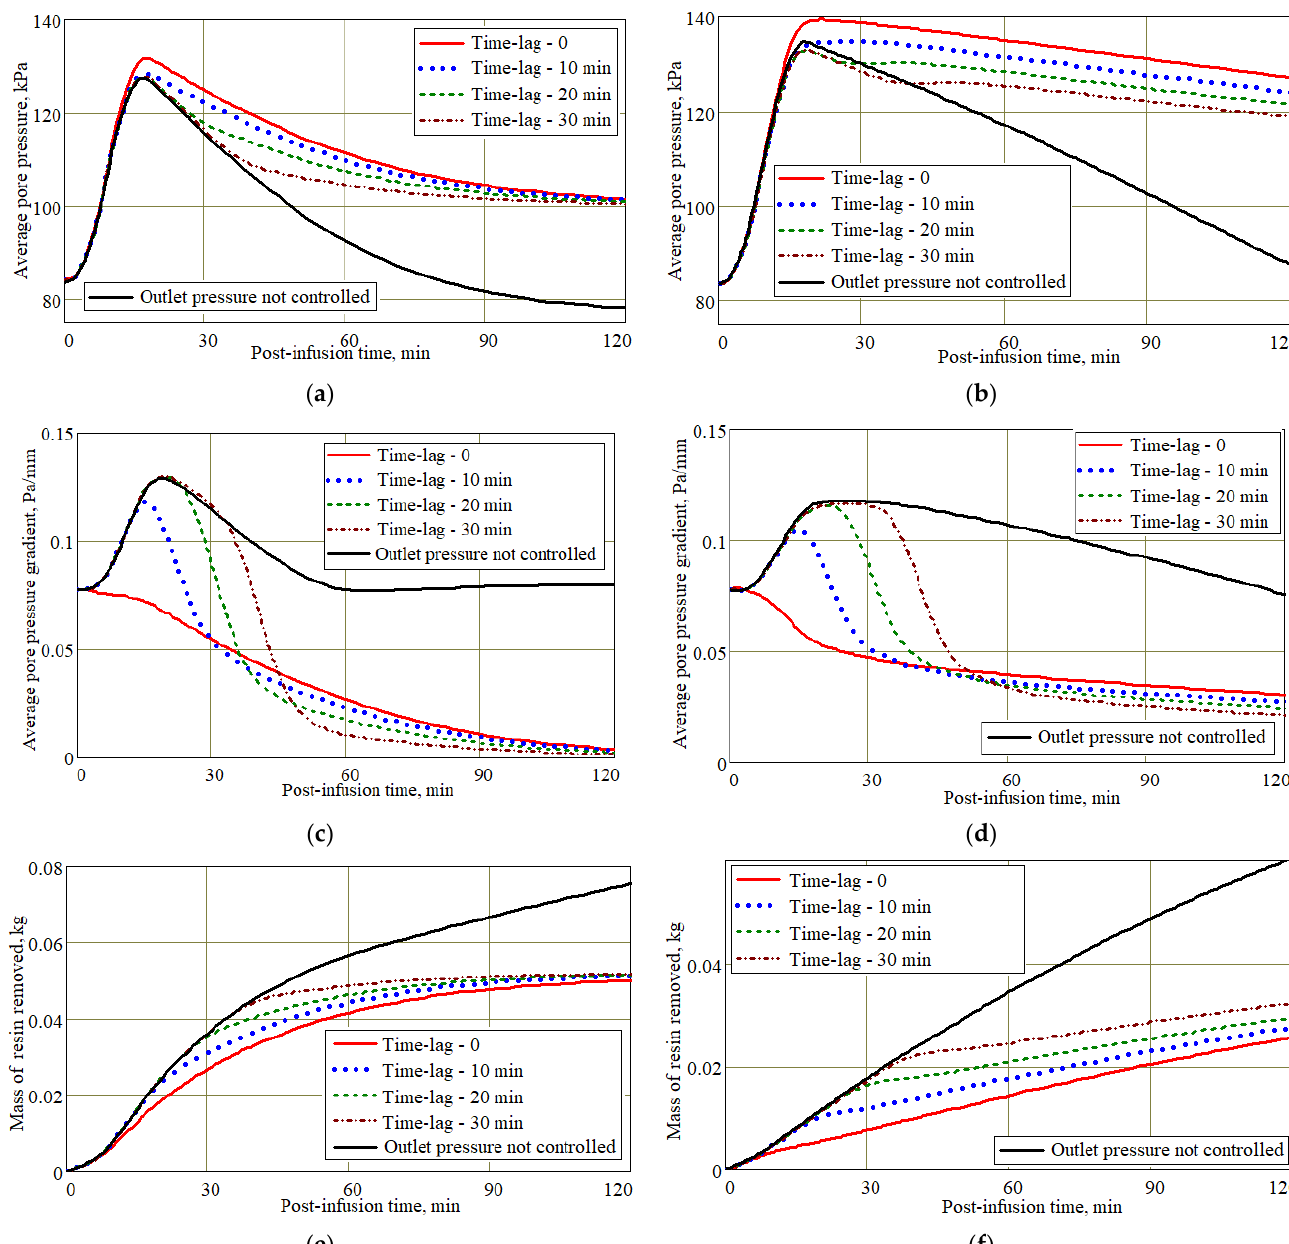
Figure 13. Time histories of average pore pressure ( a , b ), pore pressure gradient ( c , d ) and mass of the resin removed ( e , f ) from the preform during the post-infusion stage realized using different the pressure control modes. The left plots ( a , c , e ) correspond to the 1st scenario, and the right ones ( b , d , f ) correspond to the 2nd scenario.